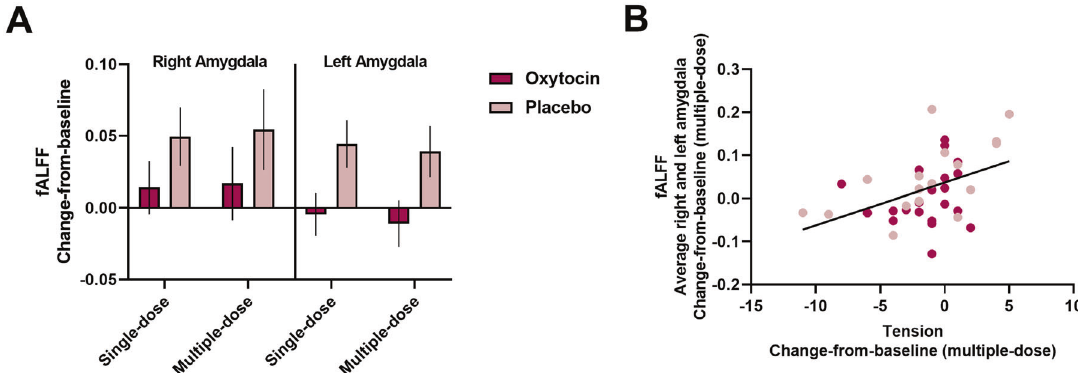
Fig. 2 Effect of single- and multiple-dose oxytocin treatment on amygdala BOLD signal amplitude. A Mean changes-from-baseline in the fractional amplitude of low-frequency fl uctuations (fALFF) are visualized separately for each treatment group (oxytocin, placebo), assessment session (single-dose, multiple-dose), and amygdala region (right, left). Data are visualized and averaged across BOLD components 1 and 2. Both after a single-dose and after multiple-dose treatment, the oxytocin group displayed signi fi cantly lower amygdalar fALFF, compared to the placebo group. Vertical bars denote ± standard errors. B Visualization of the brain-behavior relationship between multiple-dose changes- from-baseline in self-reported feelings of tension (assessed with the Pro fi le of Mood Scale) and multiple-dose changes-from-baseline in fALFF (averaged across amygdala regions and BOLD